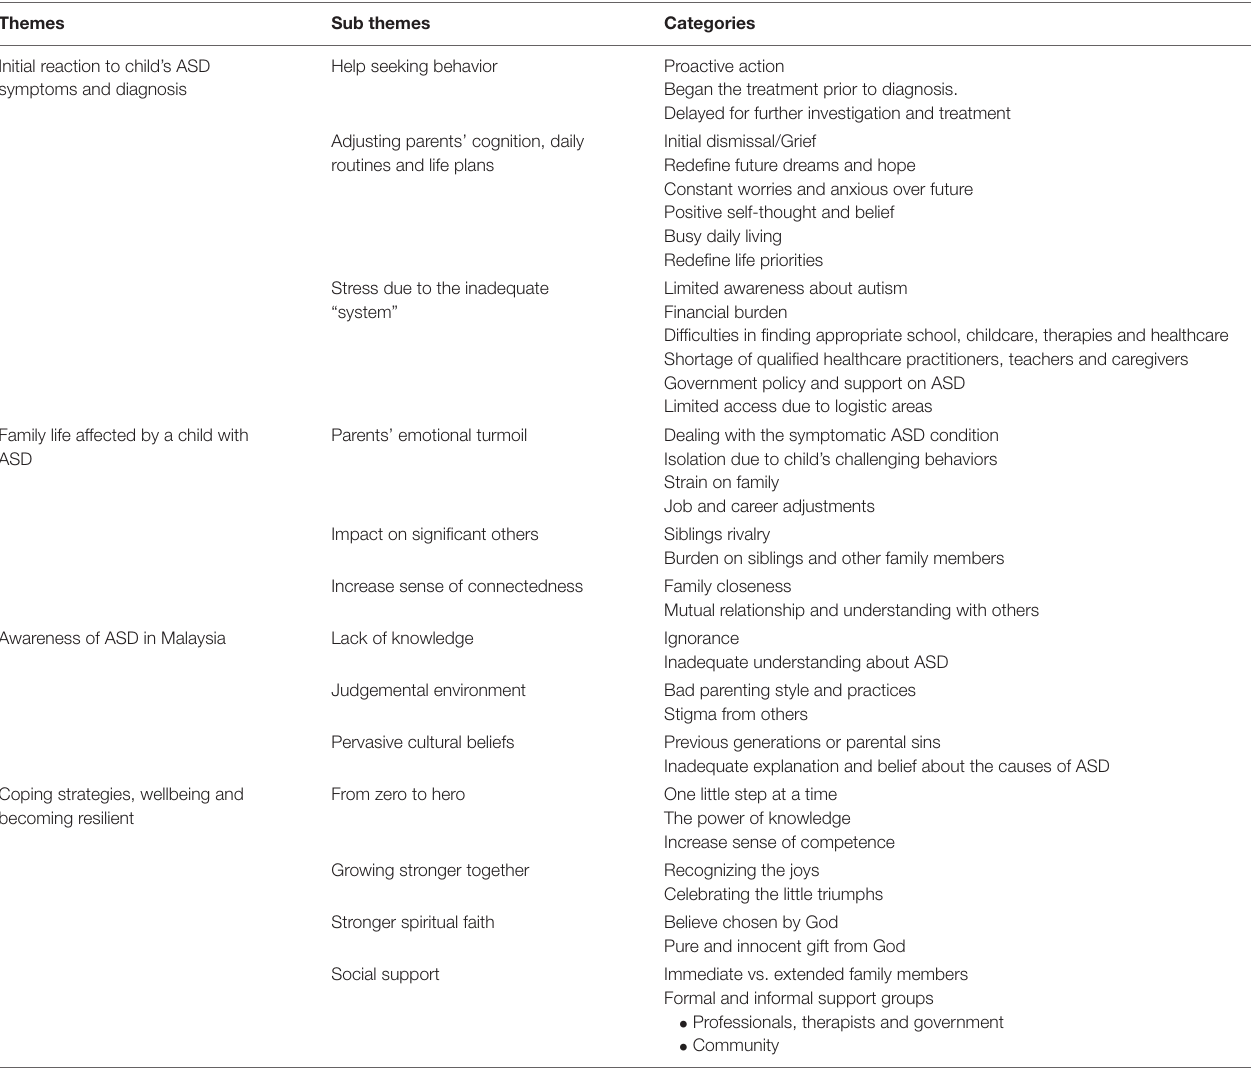
TABLE 4 | Themes, subthemes, and